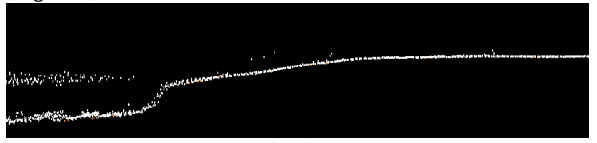
Figure.3 Profile for sandy beach.